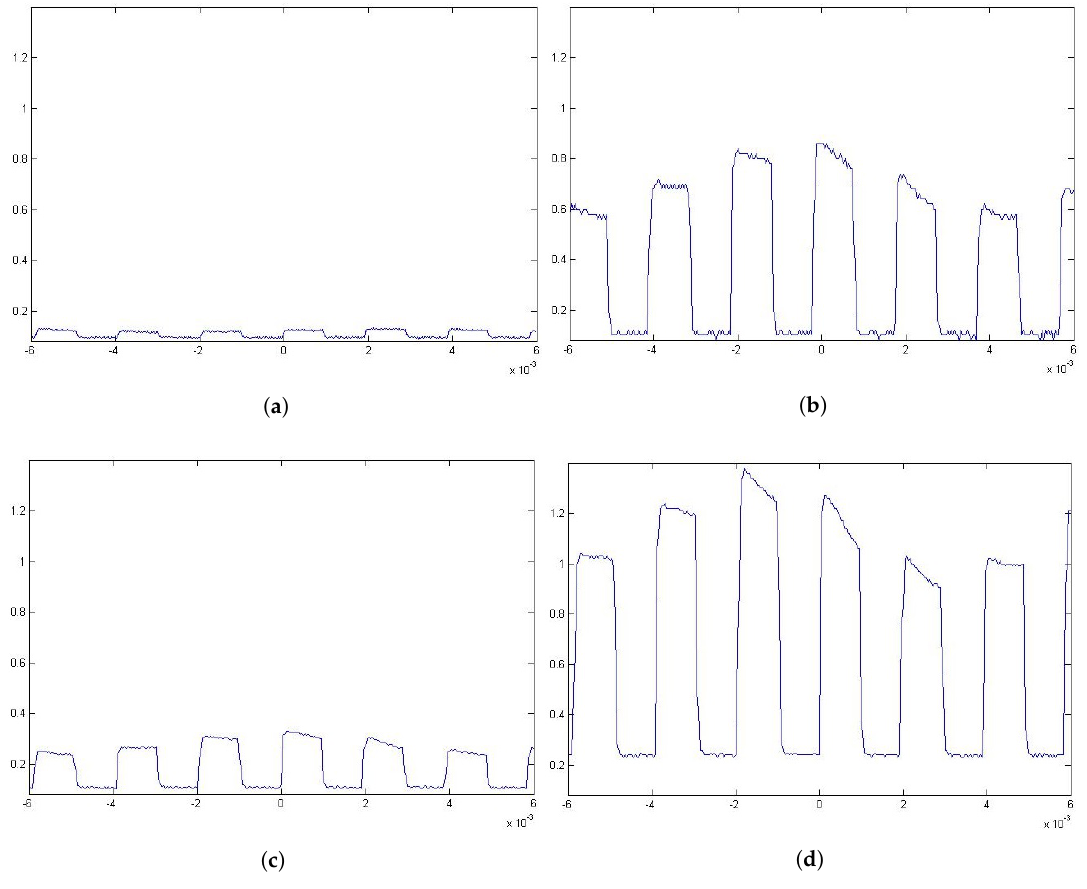
Figure 9. Captures of the signal from diferent locations: ( a ) at T1; ( b ) at T2; ( c ) at T3; and ( d ) at T4 as defined in Table 2. The emitted signal used an On-Off keying with non return to zero (OOK-NRZ) modulation scheme at a 512 bps data